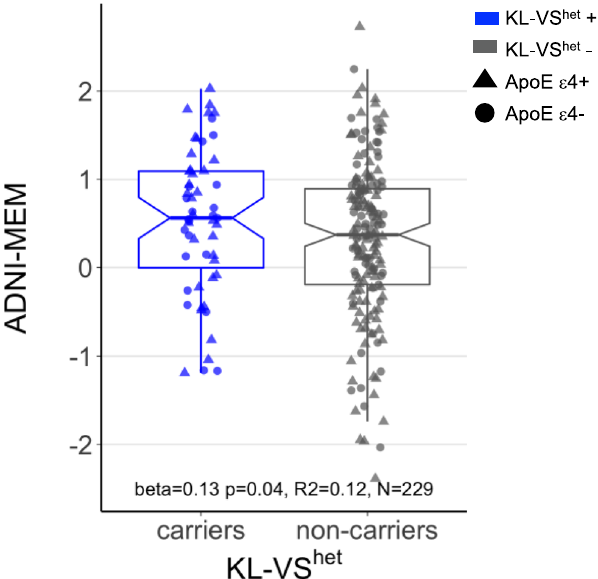
Fig. 3 Association between KL-VS heterozygosity and memory in amyloid-positive individuals. Boxplot shows memory performance as a function of KL-VS het variant in individuals with a positive amyloid-PET (SUVR FBP ≥ 1.11 or SUVR FBB ≥ 1.08). Blue and gray colors indicate individuals with heterozygous ( N = 55) or non-heterozygous KL-VS alleles ( N = 174). Memory was measured by an established composite score, ADNI-MEM, based on test performance across multiple different memory tests 39 . Statistical result of the main effect of KL-VS het on memory was derived from multiple linear regression analysis, controlled for age, sex, diagnosis, education, and ApoE ε 4 carrier status. Boxplots show the 25th percentile, median, 75th percentile (box), 95% con fi dence intervals of the median (notch), and 1.5× IQR